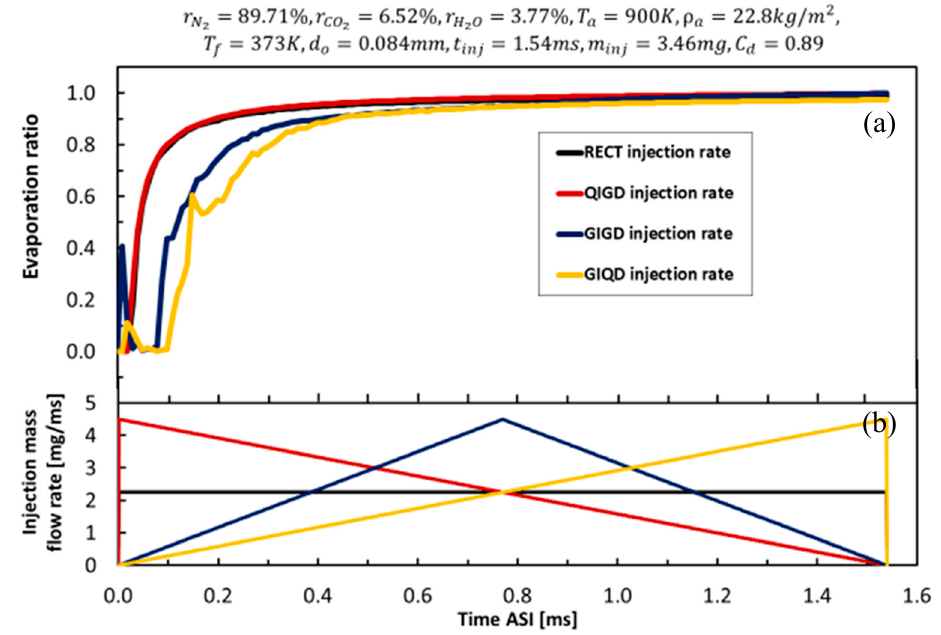
Figure 16. Comparing the evaporation ratios from the simulation results. ( a ) Evaporation ratio and ( b ) injection mass flow rate.